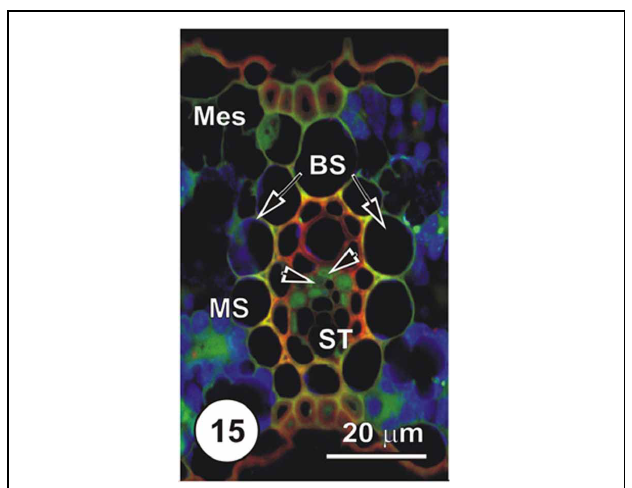
FIGURE 17 | Transection of a small intermediate transverse vein in a rice leaf, showing the distribution of 5,6-CF after uptake of 5,6-CFDA in the transpiration stream. 5,6-CFDA was co-transported with a weak solution of propidium iodide (red fluorescence) via the xylem for 30min. An emergent thick-walled sieve tube (paired darts), together with two longitudinal TST (arrows), contains 5,6-CF (green fluorescence). Thin walled sieve tubes (asterisks) do not contain 5,6-CF. Note that some 5,6-CF has transported symplasmically, through the bundle sheath (B) to the mesophyll (Mes). Preparation as per Figures 14 – 16